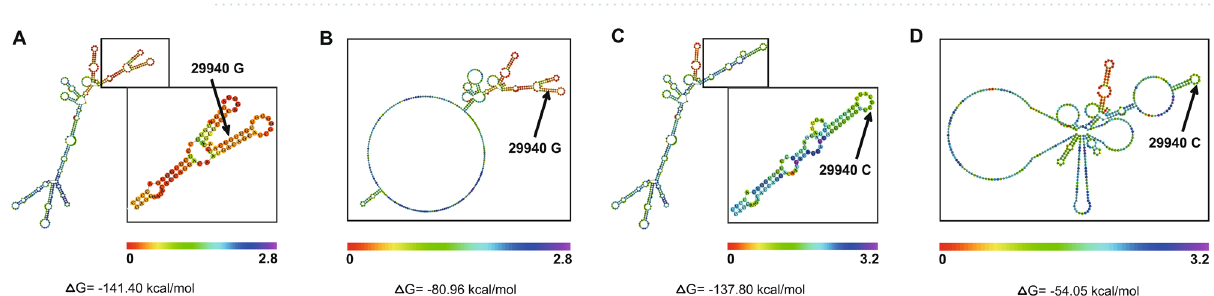
Figure 4. Prediction analysis of NLRP3 mRNA secondary structure with RNAfold Web Server. ( A , B ) showed MFE positional and centroid positional entropy, respectively, for the 29940 G allele; ( C , D ) showed MFE positional and centroid positional entropy. The higher MFE and centroid MFE values of the NLRP3 mRNA secondary structure with 29940 C mutant indicated less stable mRNA secondary with the 29940GG/GC genotypes compared with those with the CC genotype, while these differences were not observed without LPS stimulation (Fig. 3). However, no significant difference in IL-6 production was observed between PBMCs with different 29940G>C genotypes.